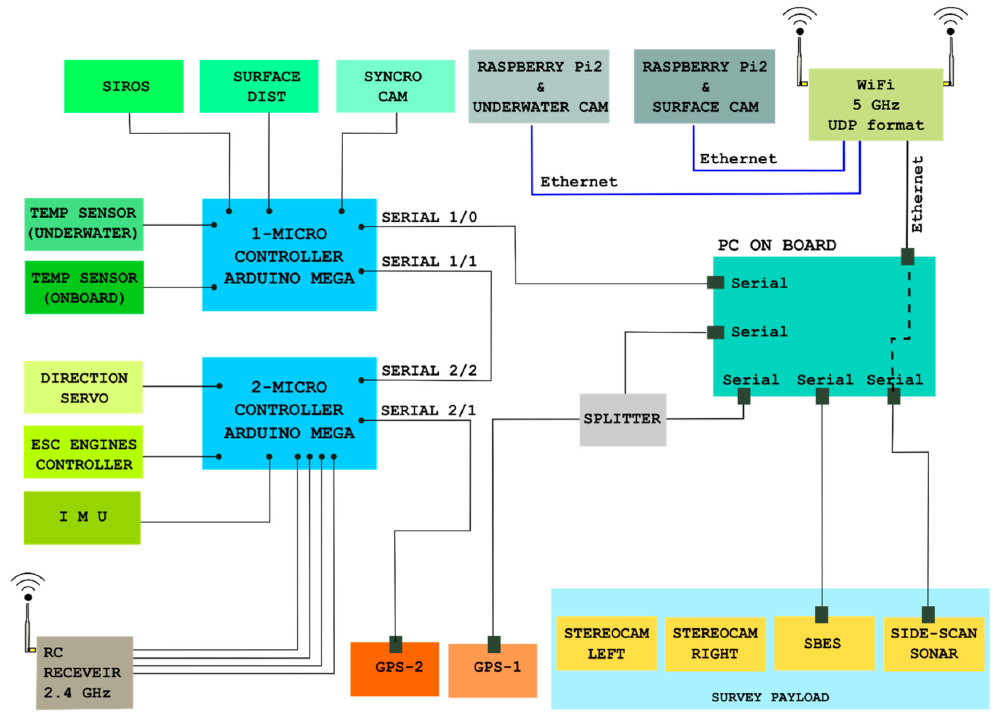
Figure 10. Block diagram of the platform management system